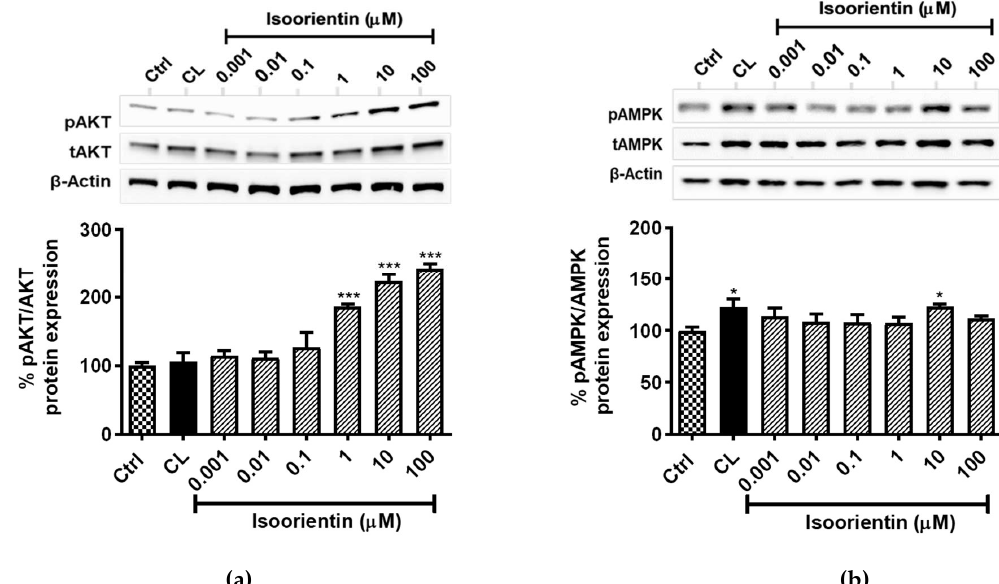
Figure 4. Isoorientin increased protein kinase B (pAKT), ( a ) 5′ AMP-activated protein kinase (pAMPK); and ( b ) protein expression in fully differentiated 3T3-L1 adipocytes. Matured 3T3-L1 adipocytes were treated with or without positive control CL-316,243 (CL), isoproterenol (Isopr) used at 1 μM and various doses of isoorientin (0.001, 0.01, 0.1, 1, 10, and 100 μM) for 4 hours; thereafter, proteins were extracted for Western blot analysis. Results are expressed as mean ± SEM of three independent experiments. * p < 0.05, *** p < 0.001 versus normal control (Ctrl).